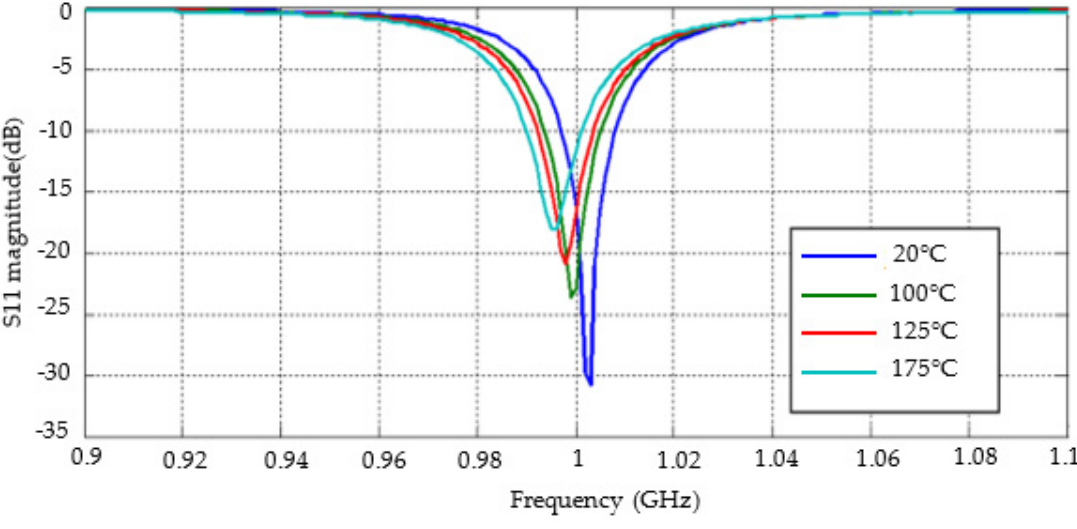
Figure 14. The S11 amplitude of the developed antenna varies with